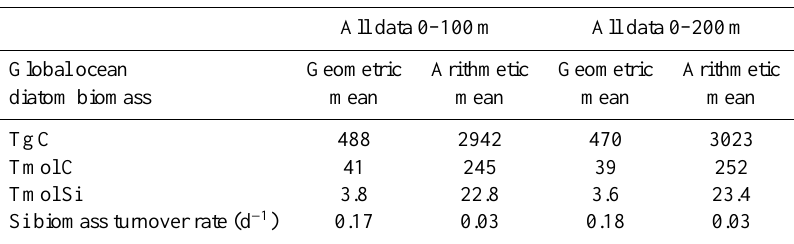
Table 4. Global ocean budget of diatom biomass for the entire dataset expressed in TgC, TmolC and TmolSi, and Si biomass turnover rate estimates in d − 1 (see discussion section for calculation details).